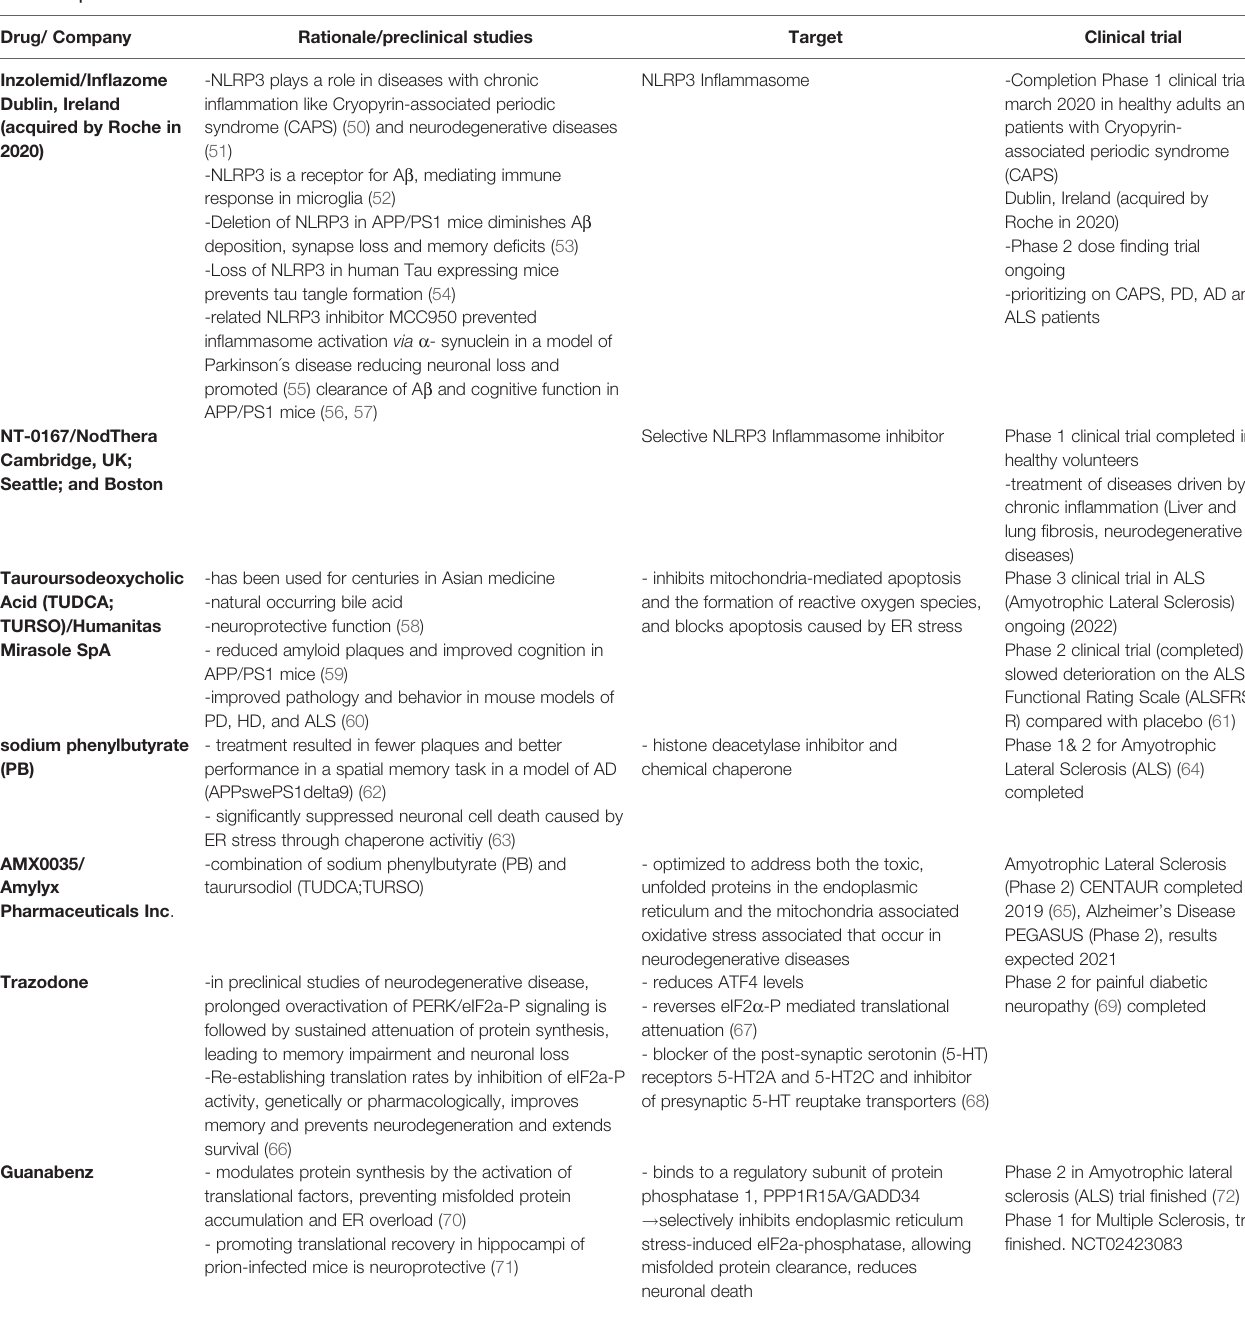
TABLE 1 | Treatments in clinical